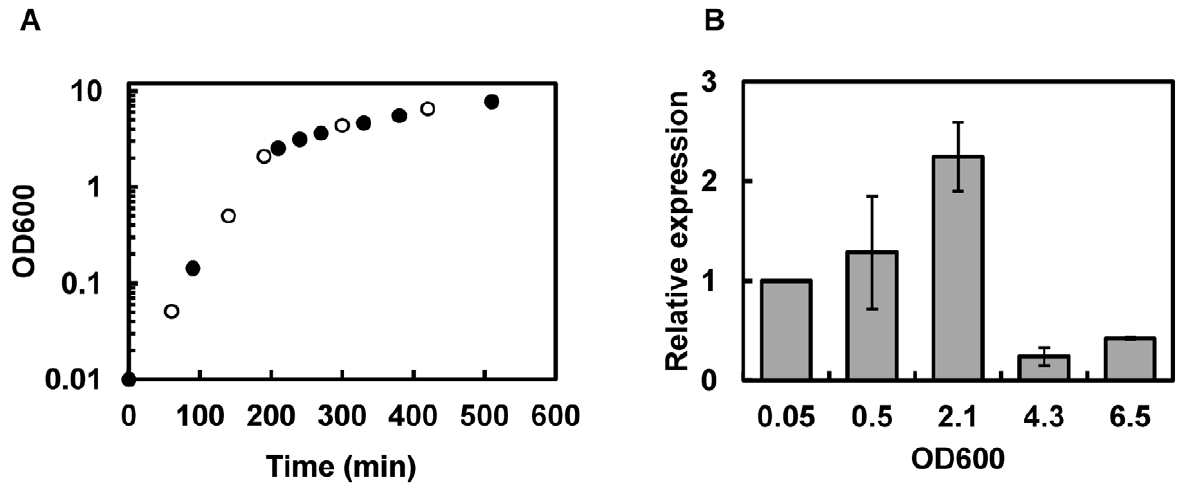
Figure 3. Growth of B.cereus ATCC14579 and expression analysis of bc4707 . A. Bacteria were grown in LB-medium. Circles indicate OD 600 measurements. Bacteria were harvested for RNA extraction (open circles). B. Gene expression analysis of bc 4707 by qRT-PCR. Averages and standard deviations from three experiments are shown. The relative expression at different OD 600 values is compared to the expression level at OD 600 of 0.05. 16S RNA was used as a control to normalize the data. doi:10.1371/journal.pone.0036720.g003 PLoS ONE |